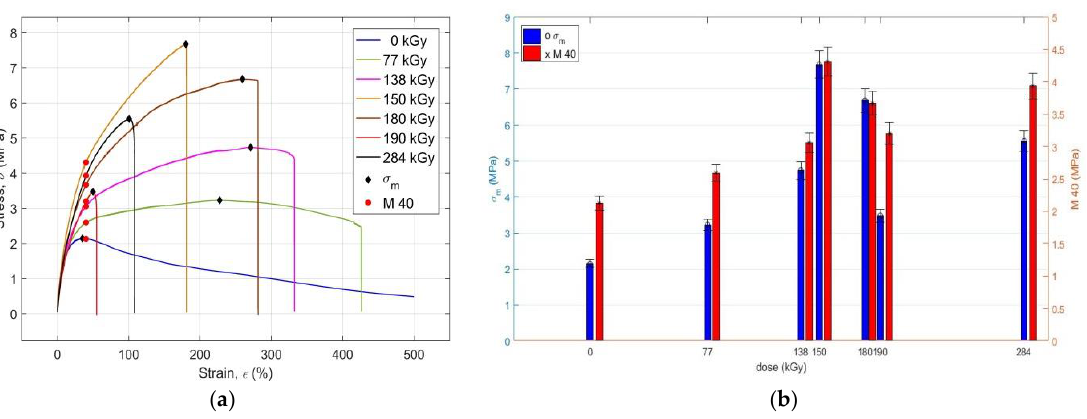
Table 1. Experimental values of mechanical characteristics ε b , σ b , σ m and M 40 for the virgin sample of PMX3 polymer system and samples irradiated with individual radiation doses.